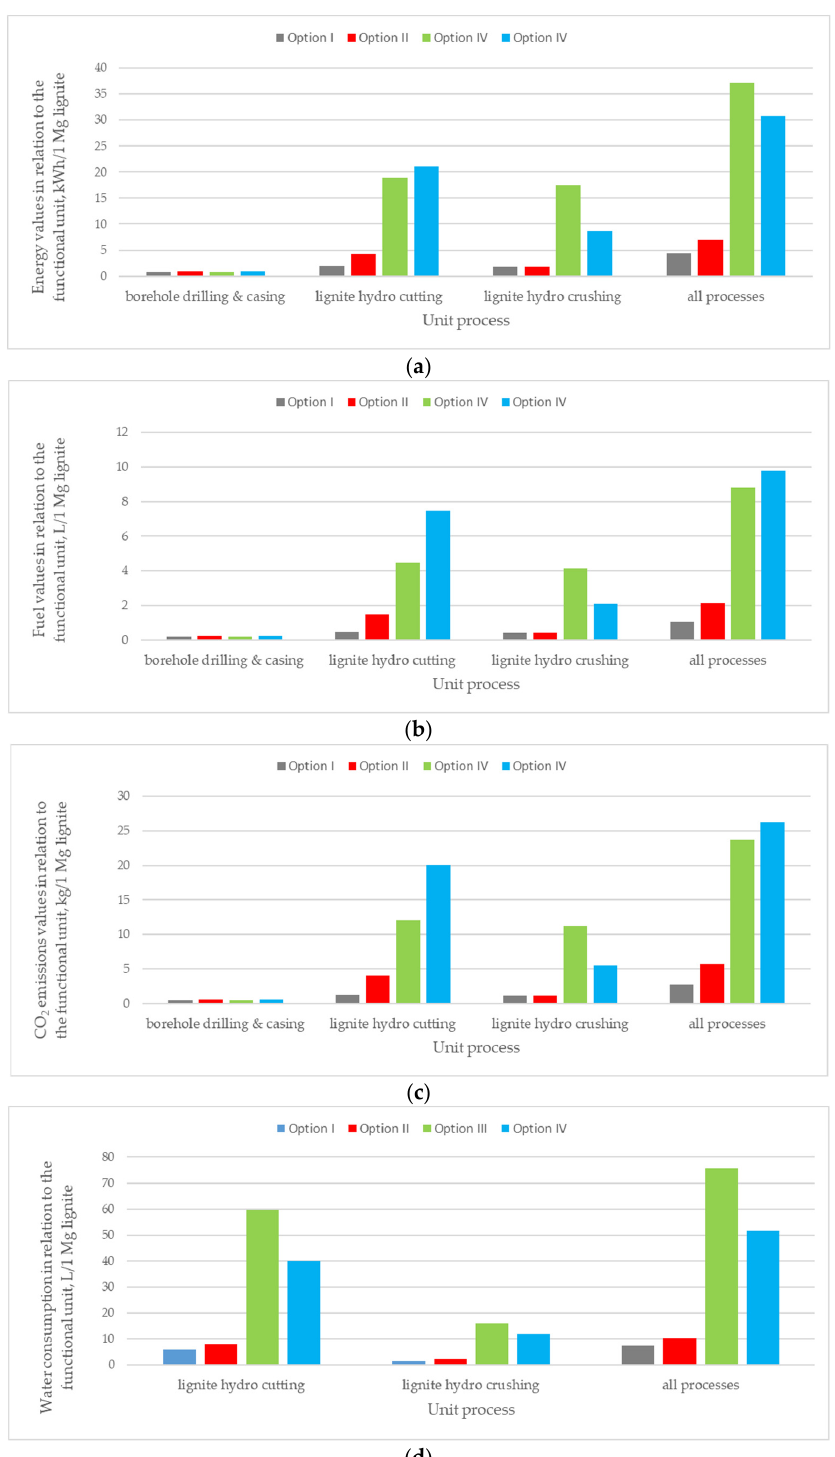
Figure 7. A comparison of unit processes energy consumption within different options and the total energy consumption for the system: ( a ) borehole drilling and casing unit process; ( b ) lignite hydro-cutting unit process; ( c ) lignite hydro-crushing unit process; ( d ) total energy consumption of the system for different